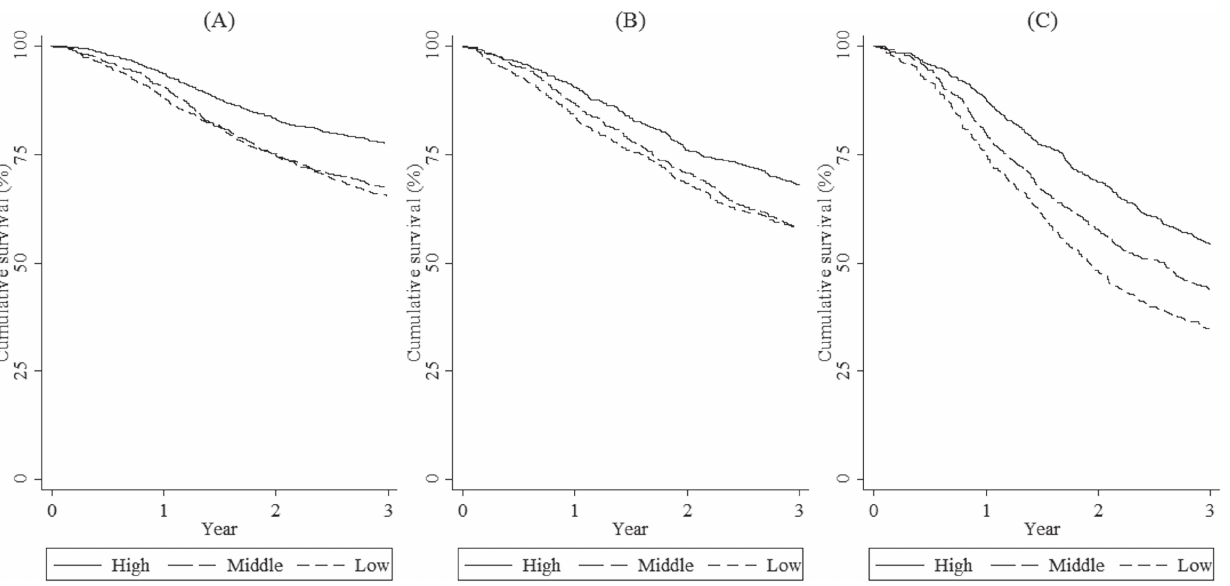
Figure 2. Kaplan-Meier estimates for 3-year survival among patients who received curative surgery for cancer at high-, middle-, and low-volume hospitals. Cancer types included are: esophagus (A), biliary tract (B), and pancreas